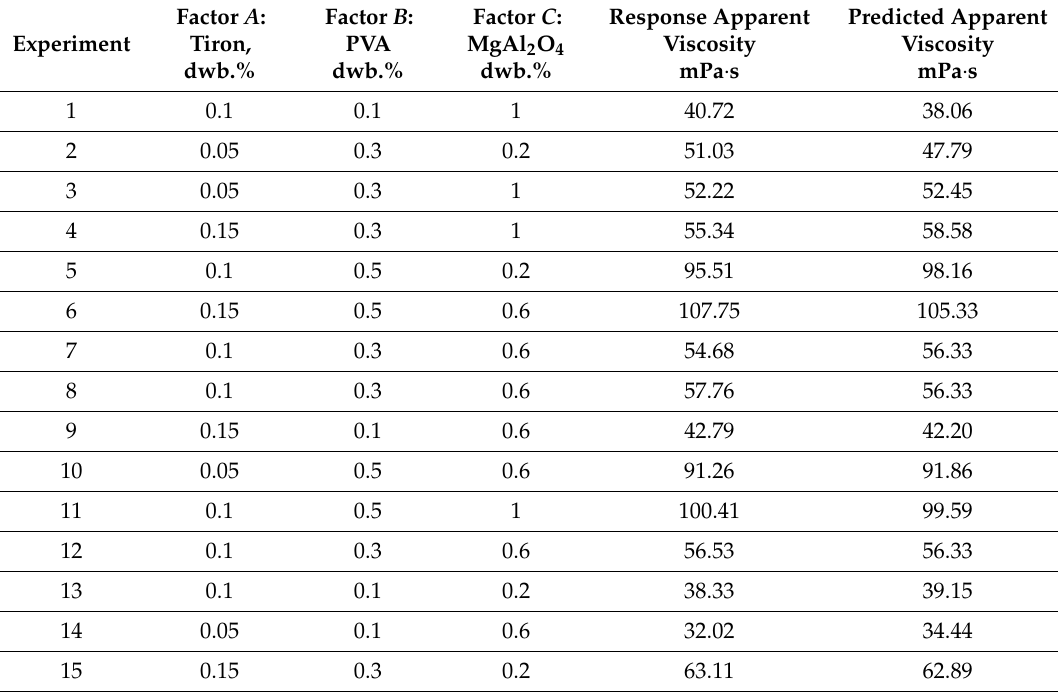
Table 1. Experimental results.